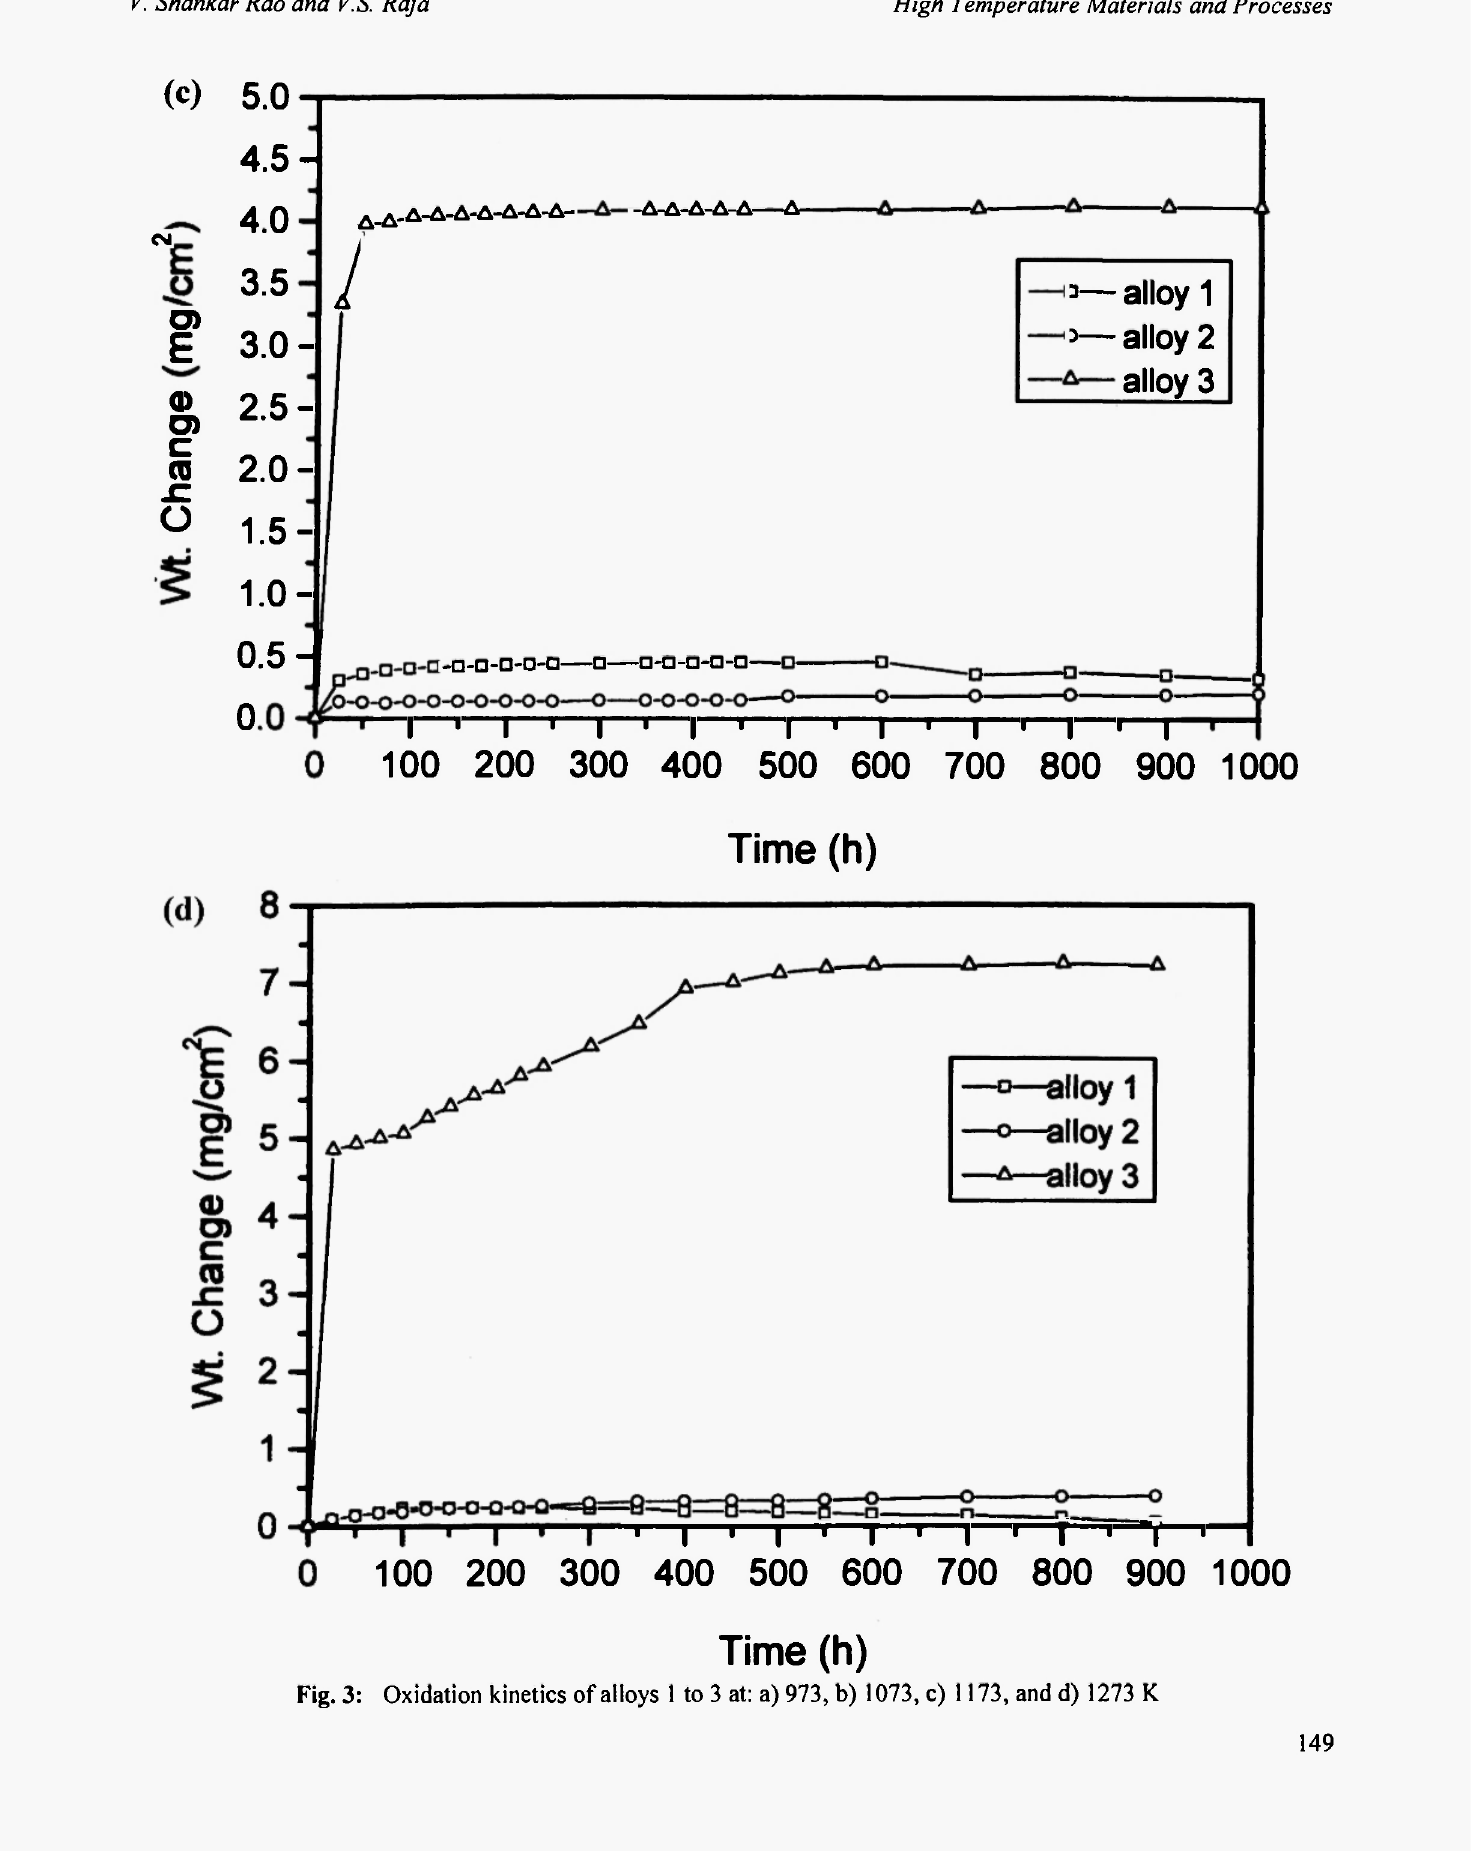
Fig. 3: Oxidation kinetics of alloys 1 to 3 at: a) 973, b) 1073, c) 1 173, and d) 1273